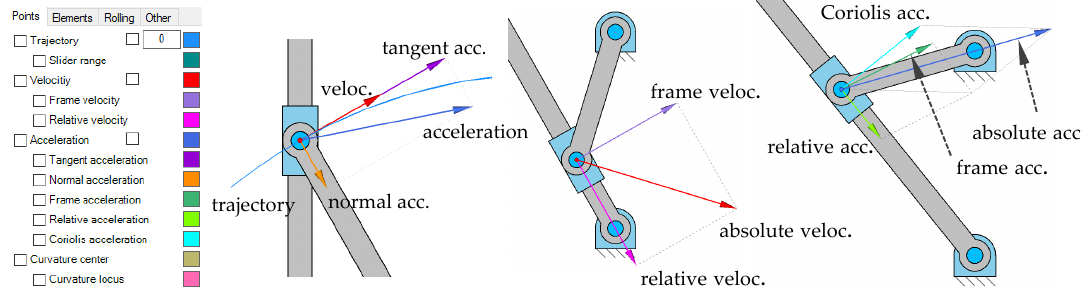
Figure 7. Visualizing decomposition of velocity and acceleration.